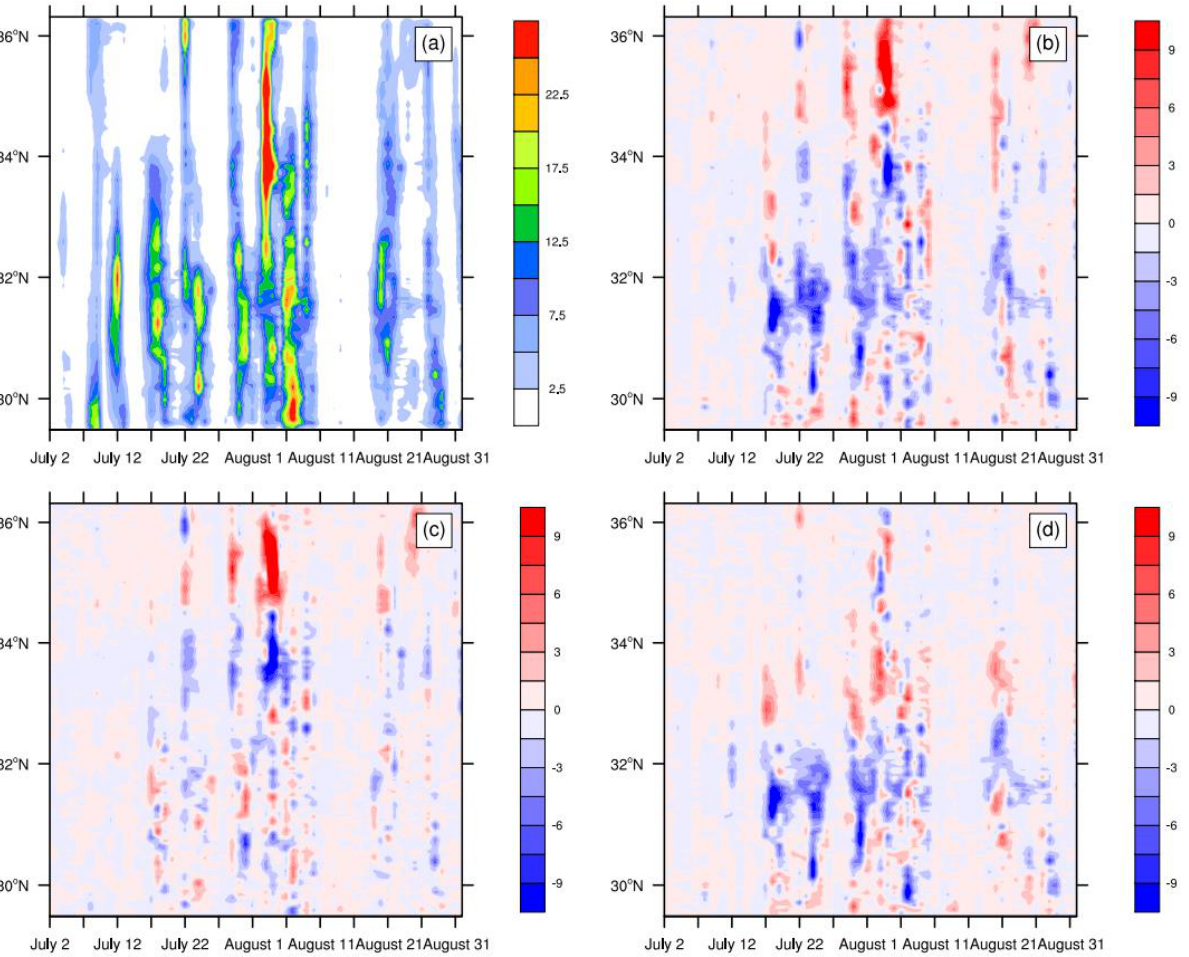
Figure 5. Time – latitude diagrams of daily accumulated precipitation (mm) averaged in domain 3 in CTRL ( a ). Panels ( b – d ) are the differences ( b ) between LowQD and CTRL (LowQD minus CTRL), ( c ) between LowQ and CTRL (LowQ minus CTRL), as well as ( d ) between LowD and CTRL (LowD minus CTRL), respectively. Blue (red) shading indicates negative (positive) variation.